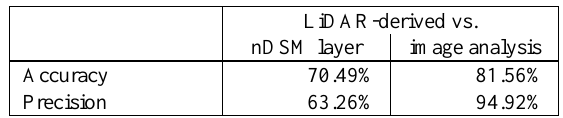
Table 4. Error assessment of cell-by-cell comparison between the rasterized maps of harvest